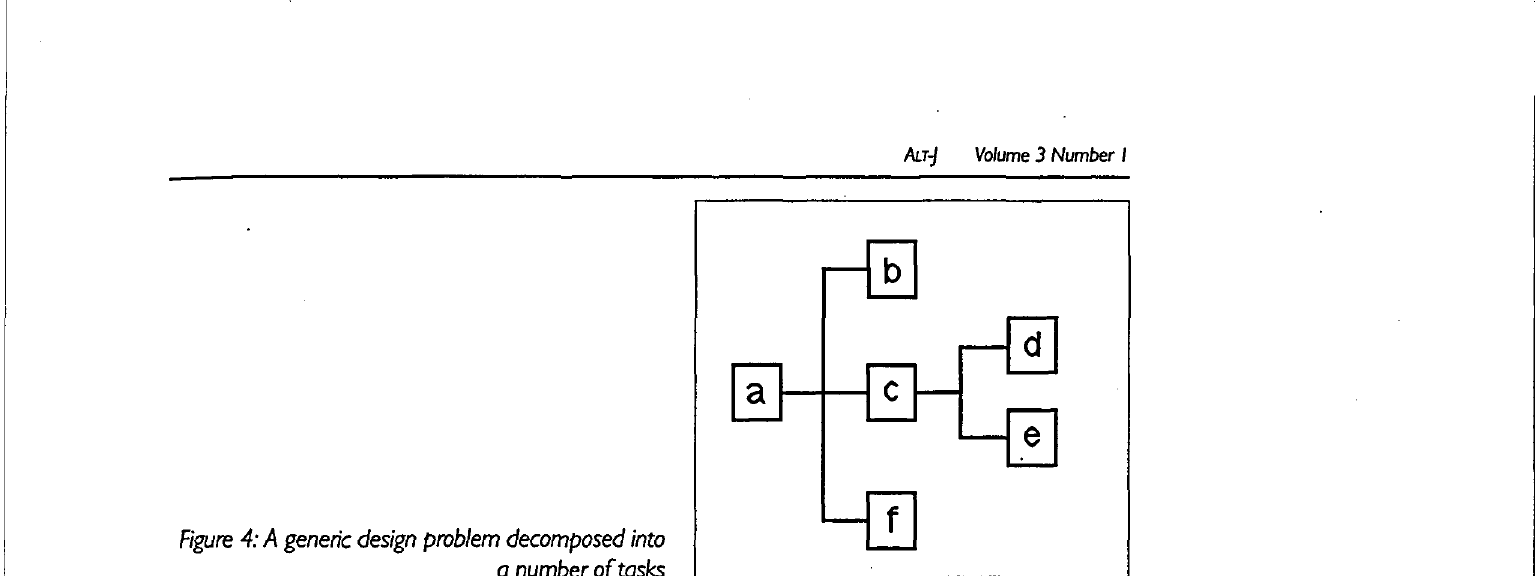
Figure 4: A generic design problem decomposed into a number of tasks